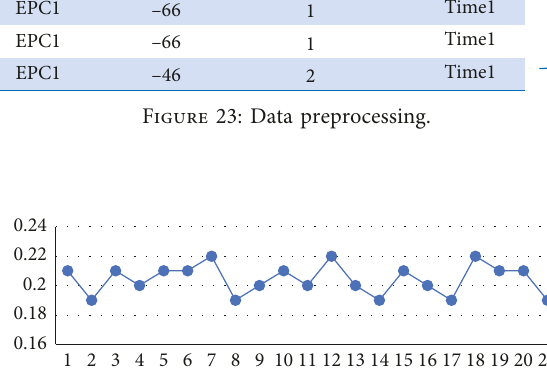
Figure 24: Distance deviation between the calculated value and the real value in a small area.